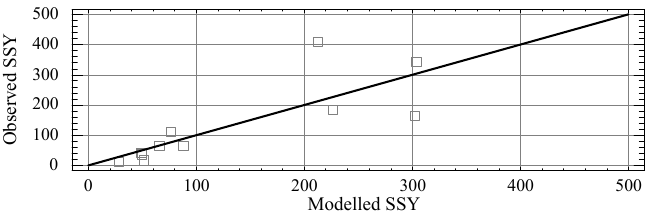
Figure 4. Plot of linear model between observed SSY obs (t/km 2 ) and modeled SSY mod2 WATEM/SEDEM (t/km 2 ) (SSY obs = 31.4649 + 0.831994 * SSY mod2 ).